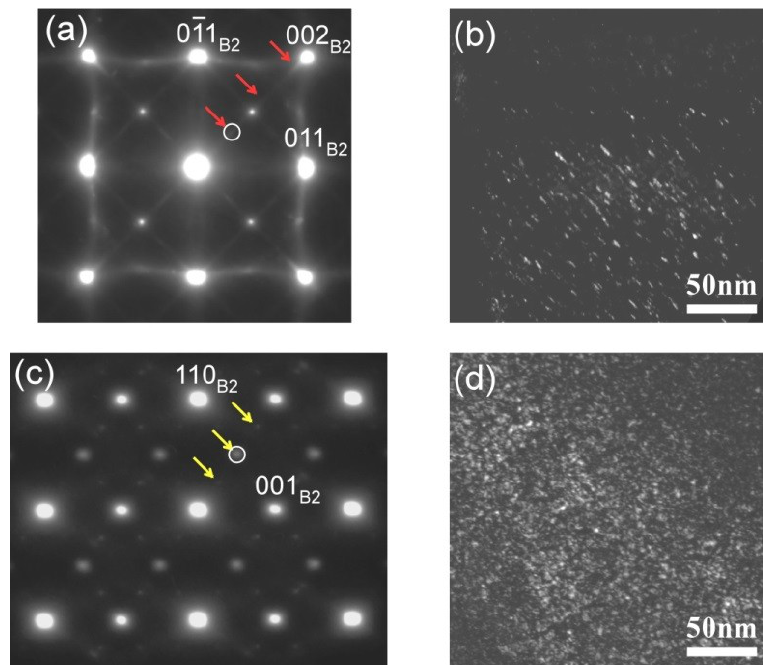
Figure 5. TEM analysis of the specimens cycled five times from 273 K to 673 K. ( a ) SADP of the 52Ti alloy; ( b ) dark field micrograph taken by the diffraction spot labeled by a circle in ( a ); ( c ) SADP of the 49Ti alloy; ( d ) dark field micrograph taken by the diffraction spot labeled by a circle in ( c ).